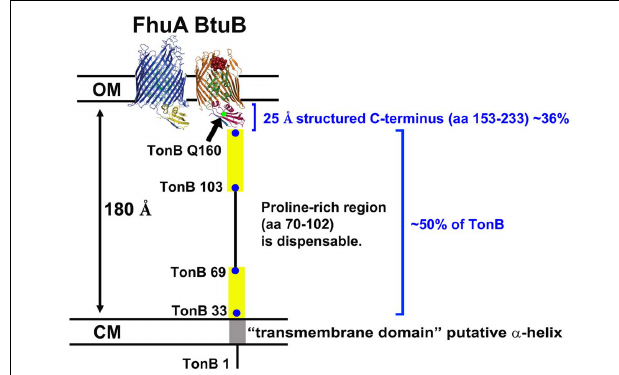
FIGURE 7 |TonB cannot reach OM transporters with the conformation depicted by crystal structures of its C terminus. TonB residues 33–69 and 103–149, predicted to be disordered regions (Larsen et al., 2007), are depicted as yellow rectangles.The span of the periplasmic space was estimated based on crystal structure reconstructions of the AcrA/B/TolC complex (Symmons et al., 2009). Abbreviations: CM, cytoplasmic membrane; OM, outer